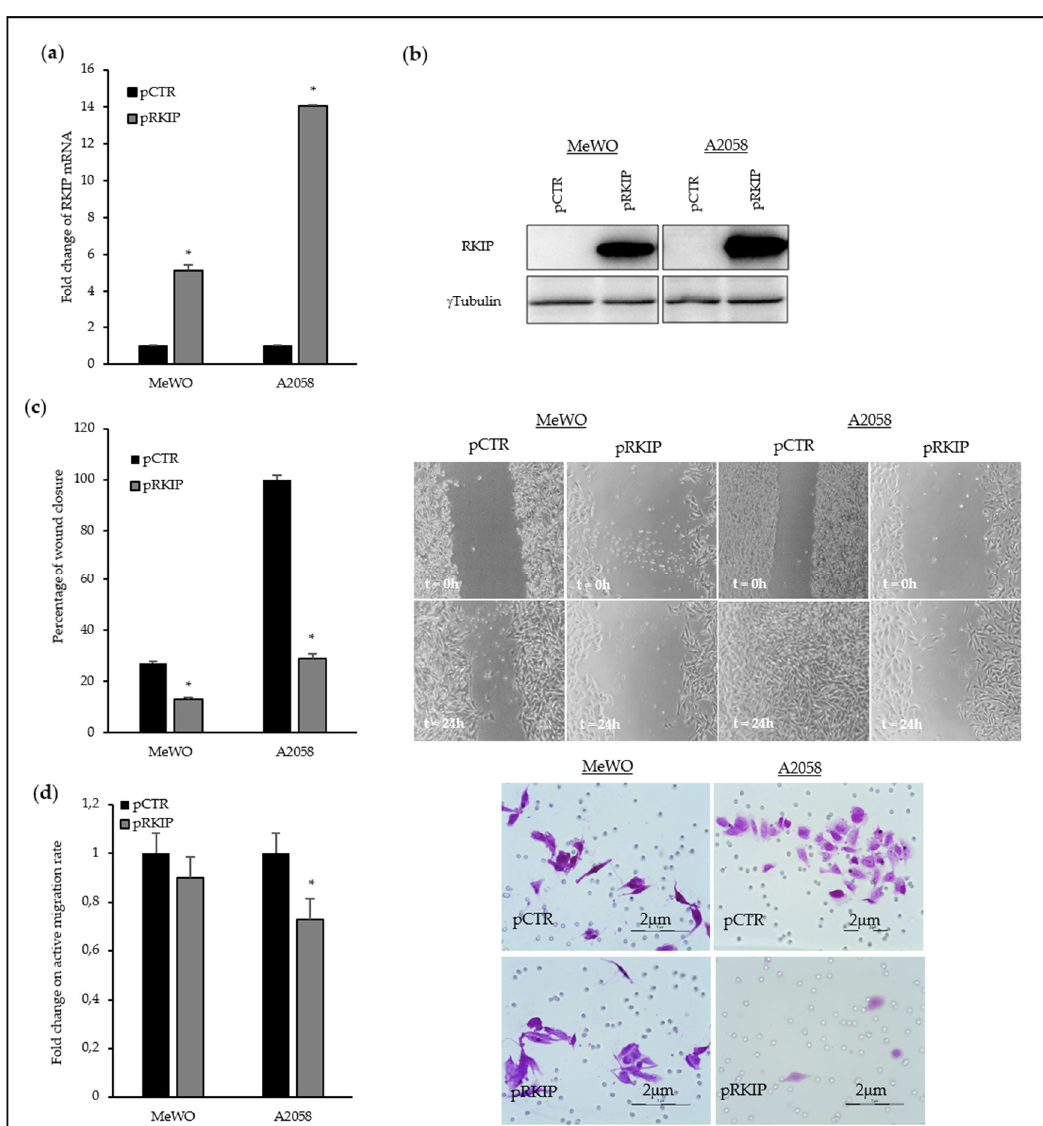
Figure 4. Modulation of RKIP expression in MeWO and A2058 metastatic melanoma cell lines. ( a ) RKIP mRNA levels in RKIP-upregulated MeWO and A2058 metastatic melanoma cell lines. A2058 and MeWO cell lines were transfected with overexpressing plasmid for RKIP (pRKIP) or empty plasmid (pCTR) using Lipofectamine 2000 as transfection agent. All of the transfection experiments were performed with 500 ng of DNA. ( b ) Western Blot assay showed the RKIP-upregulation in MeWO and A2058 melanoma cells; ( c ) Fold change on wound healing rate in MeWO and A2058 metastatic melanoma after RKIP upregulation. The experimental assays were performed at least after 24 h of RKIP transfection; ( d ) Fold change on active migration rate in presence of collagen in metastatic melanoma after RKIP upregulation. The histograms in ( c ) and ( d ) show the average of three independent assays with six replicates per assay and representative pictures have been included. * p -value < 0.05.